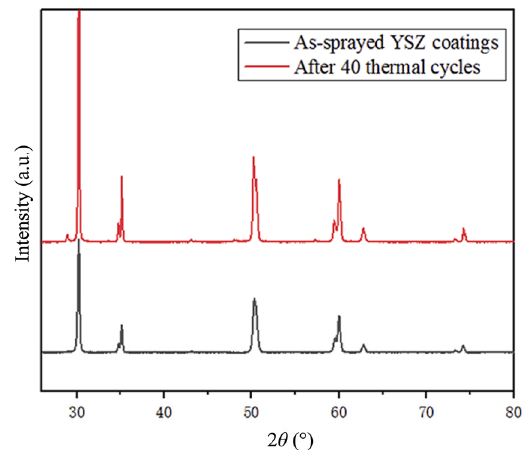
Fig. 10 XRD patterns of the as-sprayed YSZ coatings and YSZ coatings after 40 thermal